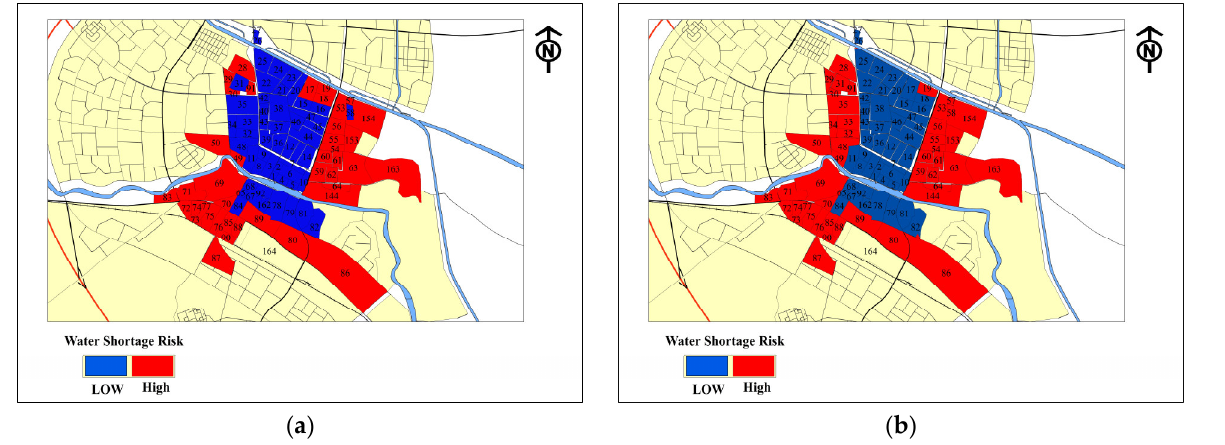
Figure 9. Map ( a ) was created by the direct representative method in GIS, using the prediction results of MLP algorithm, whereas map ( b ) was produced by the WLC technique of GIS using the criteria weights gained from MLP algorithm.